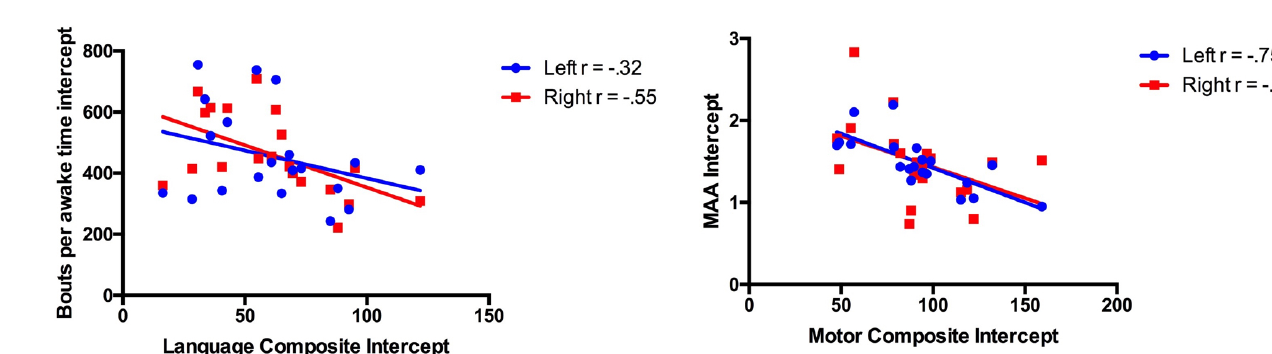
Figure 4. Scatter plot of bouts per awake time intercepts (for right and left arms) and Bayley composite language intercepts of each infant.